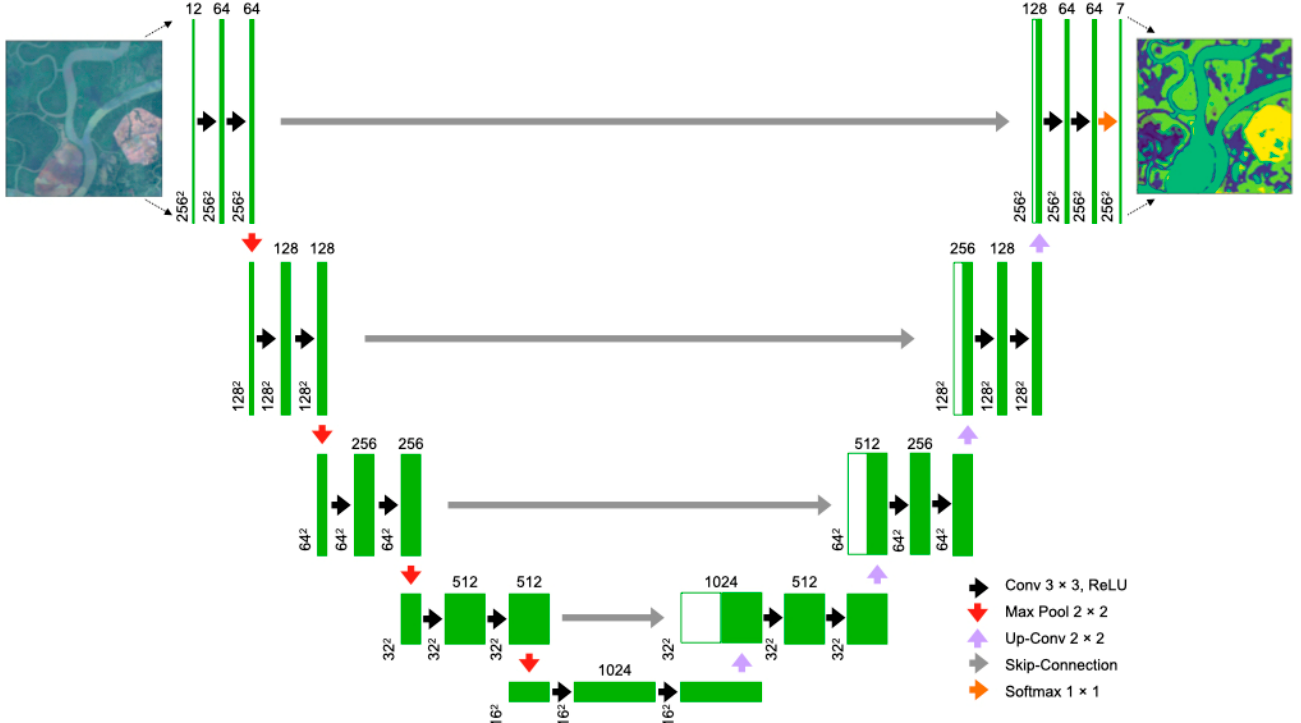
Figure 2. The proposed U-Net architecture was adapted from Ronneberger et al. [50]. The model’s inputs were patches of size 256 × 256 pixels with 12 bands (here, the input image is shown as an RGB image for visualisation purposes). The green boxes represent an image as it progresses through the U-Net, with modified pixel sizes (bottom-left of boxes) and number of channels (bands) (top of boxes). The output is a single-channel image with a user-defined number of classes (here, seven).